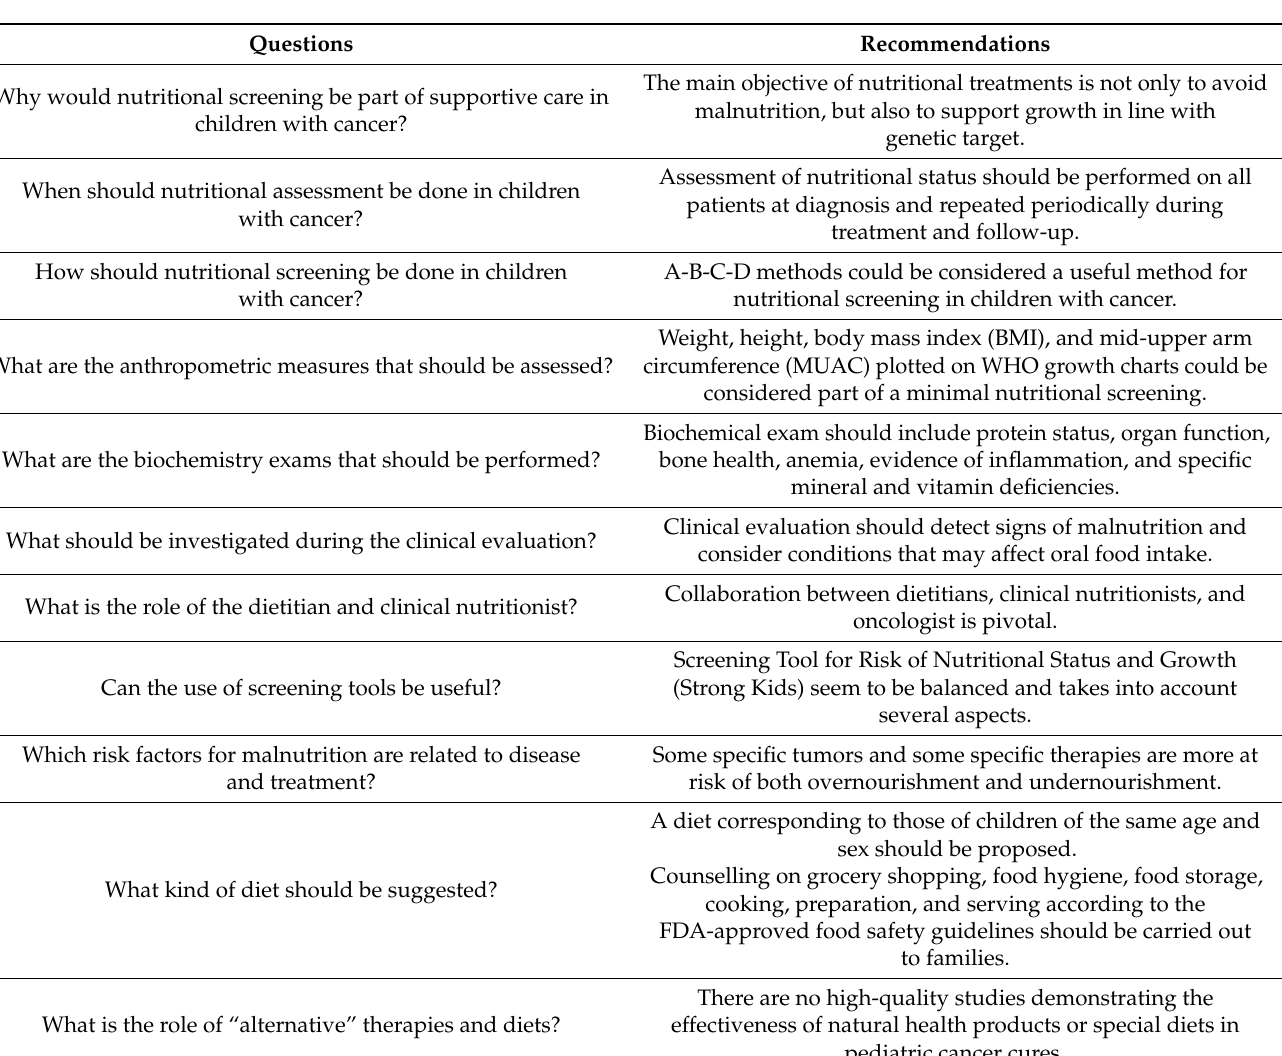
Table 1. Summary of